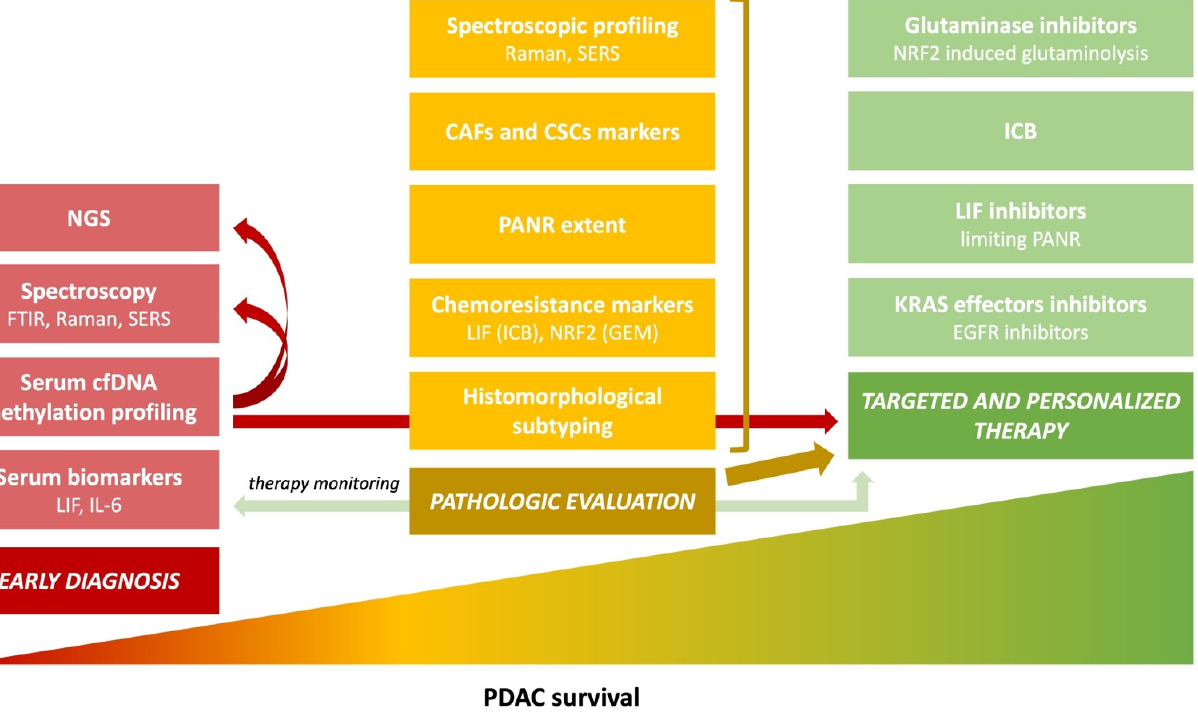
Figure 1. Main trends in PDAC pathology and research that are expected to improve survival. Poor PDAC patients’ prognosis is multifactorial—no sensitive and specific early diagnostic methods is one of the reasons. Another is the resistance to available therapeutic options, which is caused, among other things, by the tumor’s molecular and morphological heterogeneity. Detailed pathological reporting is crucial for targeted and personalized therapy. The development of new diagnostic methods, combined with a proper pathologic evaluation and spectroscopic profiling, leads to effective treatment. Altogether, this will increase PDAC patients’ survival rates. PDAC, pancreatic ductal adenocarcinoma; LIF, leukemia inhibitory factor; IL-6, interleukin-6; cfDNA, cell-free DNA; FTIR, Fourier transform infrared spectroscopy; Raman, Raman spectroscopy; SERS, surface-enhanced Raman spectroscopy; NGS, next-generation sequencing; ICB, immune checkpoint blockers; NRF2, nuclear factor-erythroid 2–related factor 2; GEM, gemcitabine; PANR, PDAC-associated neural remodeling; CAFs, cancer-associated fibroblasts; CSCs, cancer stem cells; EGFR, epithelial growth factor receptor.